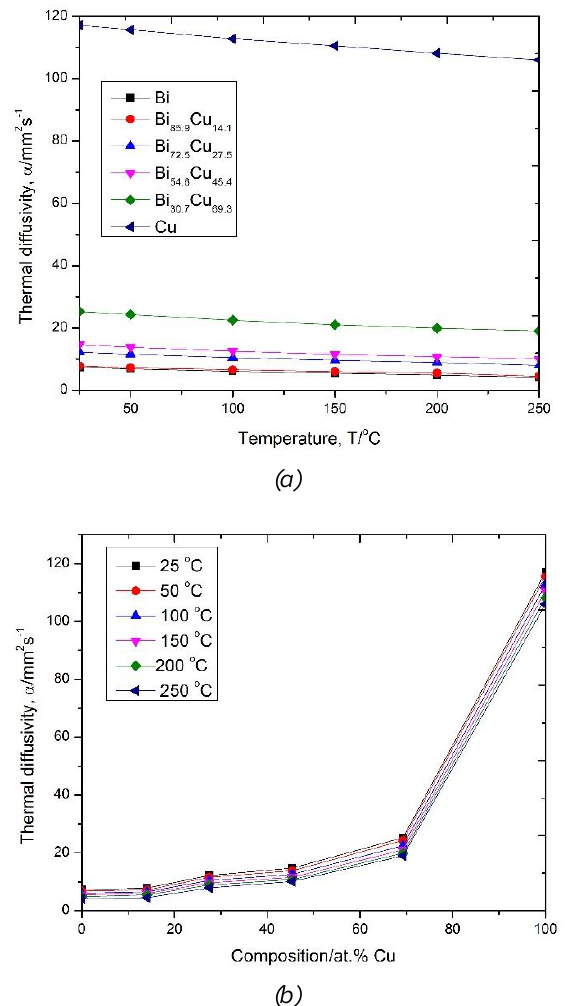
Fig. 8. Thermal diffusivity variations for the studied Bi-Cu alloys and the pure constitutive metals Bi and Cu: (a) with temperature; (b) with composition. The obtained values of thermal diffusivity, specific heat capacity, and thermal conductivity for the Bi-Cu alloys investigated in the temperature range from 25 to 250 °C are given in Table 4. The standard uncertainty (0.68 level of confidence) for the thermal diffusivity measurements is ± 3% [21]. The total standard uncertainty for the thermal conductivity is estimated to be ± 6%